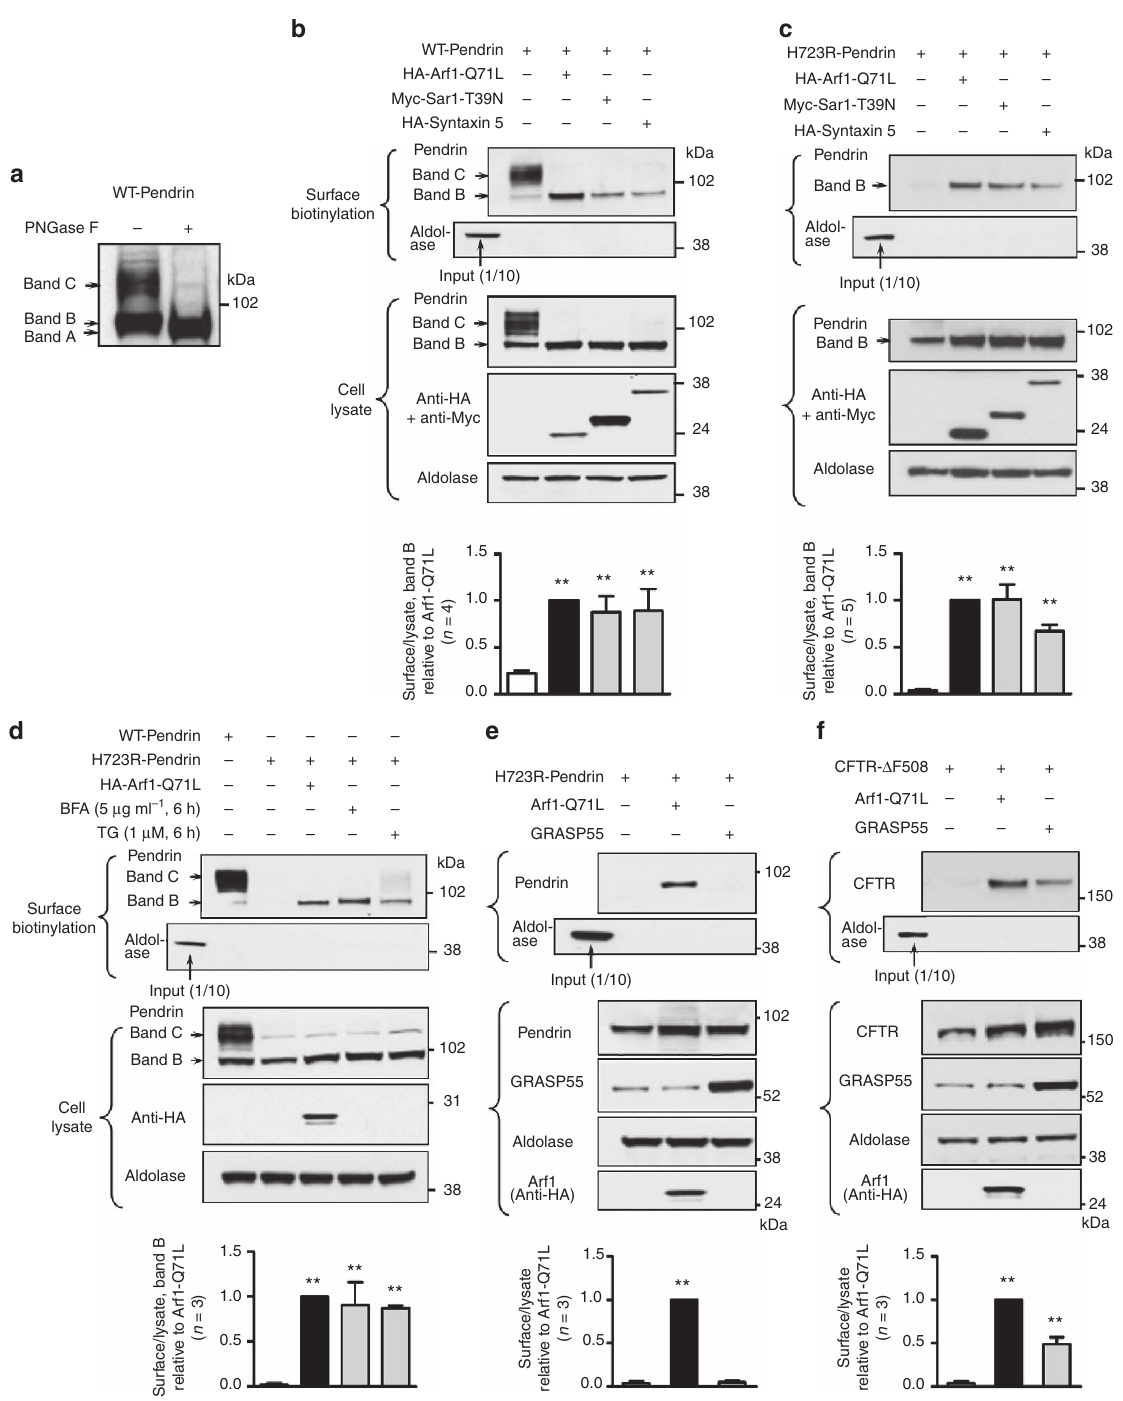
Figure 1 | Cell-surface expression of H723R-pendrin by unconventional protein secretion. ( a ) PANC-1 cells were transfected with plasmids encoding wild- type (WT)-pendrin. Protein samples were treated with N -glycosidase F (PNGase F), which deglycosylates all N -glycan chains and immunoblotted with anti- pendrin antibodies. Band A: deglycosylated pendrin, band B: immature core-glycosylated pendrin, band C: mature complex-glycosylated pendrin. ( b , c ) Surface biotinylation assays were performed in PANC-1 cells expressing WT- ( b ) or H723R- ( c ) pendrin. In control cells (first lanes in b and c ), the band C form of WT- pendrin and no form of H723-pendrin were expressed on the cell surface. Blockade of ER-to-Golgi traffic by overexpression of Arf1-Q71L, Sar1-T39N or syntaxin 5 induced the cell-surface expression of core-glycosylated (band B) WT- and H723R-pendrins. The absence of the cytosolic protein aldolase A in the biotinylated